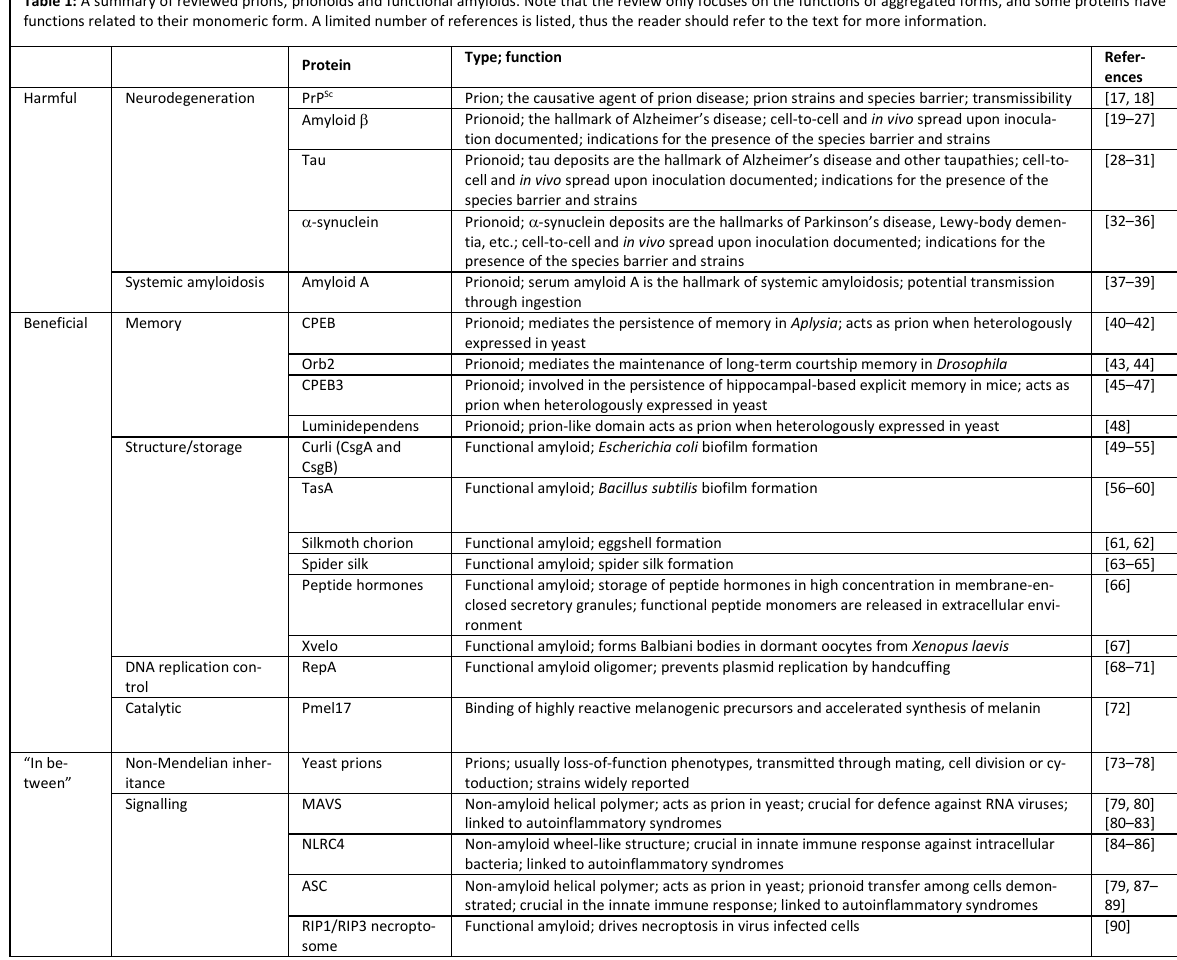
Table 1: A summary of reviewed prions, prionoids and functional amyloids. Note that the review only focuses on the functions of aggregated forms, and some proteins have functions related to their monomeric form. A limited number of references is listed, thus the reader should refer to the text for more information. Protein Type; function Refer-